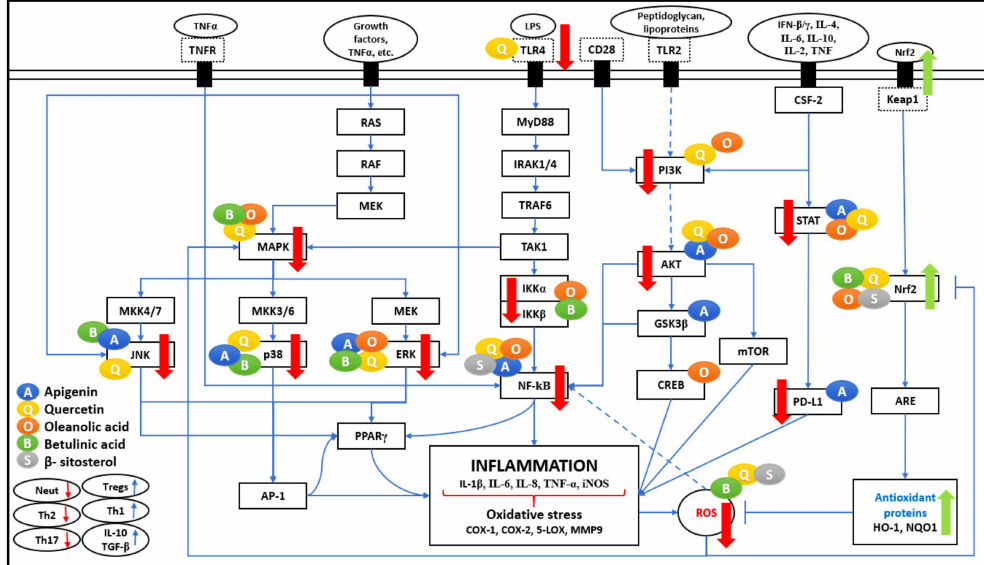
Figure 1. Inflammation pathogenesis network. The five bioactive compounds detailed in this review show a range of immunomodulatory activities. Various research articles have reported the multi- faceted effects of bioactive compounds on significant pathways such as NF- κ B, MAPK, PI3K/AKT, JAK-STAT, and the Nrf2 pathway. These bioactive compounds are shown as coloured circles and are indicated alongside their respective molecular targets (Blue: Apigenin, Yellow: Quercetin, Orange: Oleanolic acid, Green: Betulinic acid, Grey: β -Sitosterol). The bold red arrows indicate the downreg- ulation of respective pathways, and bold green arrows indicate the upregulation of the antioxidant pathway. The entities of bold square boxes represent different signaling molecules/complexes. The entities of dotted square boxes represent different receptors for signaling pathways. The entities of circle boxes represent the inducers/activators of the particular pathways (top) and immune responses (bottom left). → represents direct activation, —> represents indirect activation, and (cid:97) represents